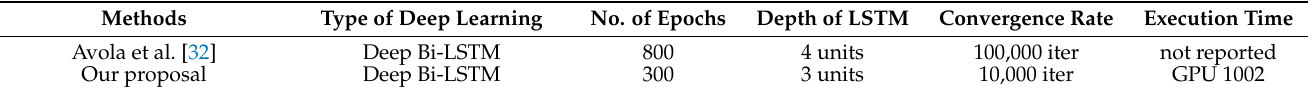
Table 10. Comparison of adopted Deep Bi-LSTM with a state-of-the-art method.